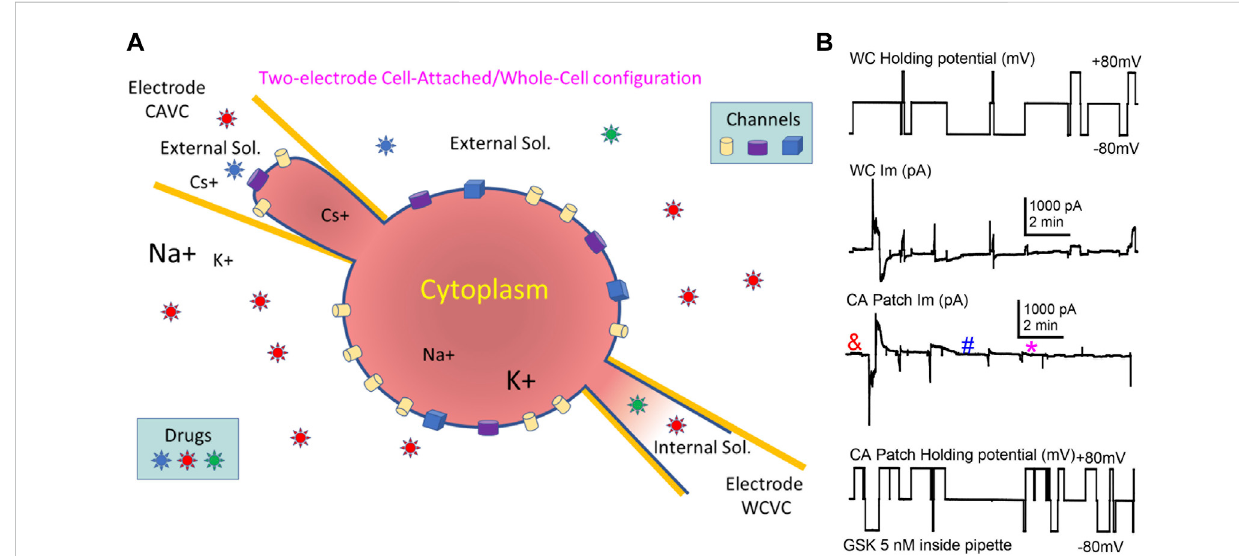
The combination of Cell-Attached and Whole-Cell (CA/WC) modes in a single cell enabled therecording of channels inducedby GSK1016790A. (A) IllustrationofCA/WCVoltageClampcon fi gurationinsinglecell.Voltagepulsescanbeappliedoneitherside(intracellularorextracellular)oftheattached patch, and Im is recorded from both sides as mirror images. Drugs can be applied intracellularly or extracellularly (in the bath or through the CA pipette), and channels partaking of a large Im increase in the whole cell can be documented. (B) Example of a WC/CA recording. Voltage applied to the WC (top) or the CA (bottom) side, and the corresponding induced currents (middle traces) are displayed. After achieving WCVC with one electrode fi lled with internal solutions, thecell wasapproachedwith asecondelectrodecontaining5 nM TRPV4agonistGSK1016790A dilutedinexternal solution, and CAVC was quickly achieved. Pulses to ±80 mV were alternately applied to either side, while keeping the opposite at 0 mV. Notice that after a short delay ( < 1 min), a transient increase of gm (larger Im values) occurred that seem to reside on the membrane patch alone. Channel events were detected before (&) and after (# and * ) the gm increase (see Figure 8).